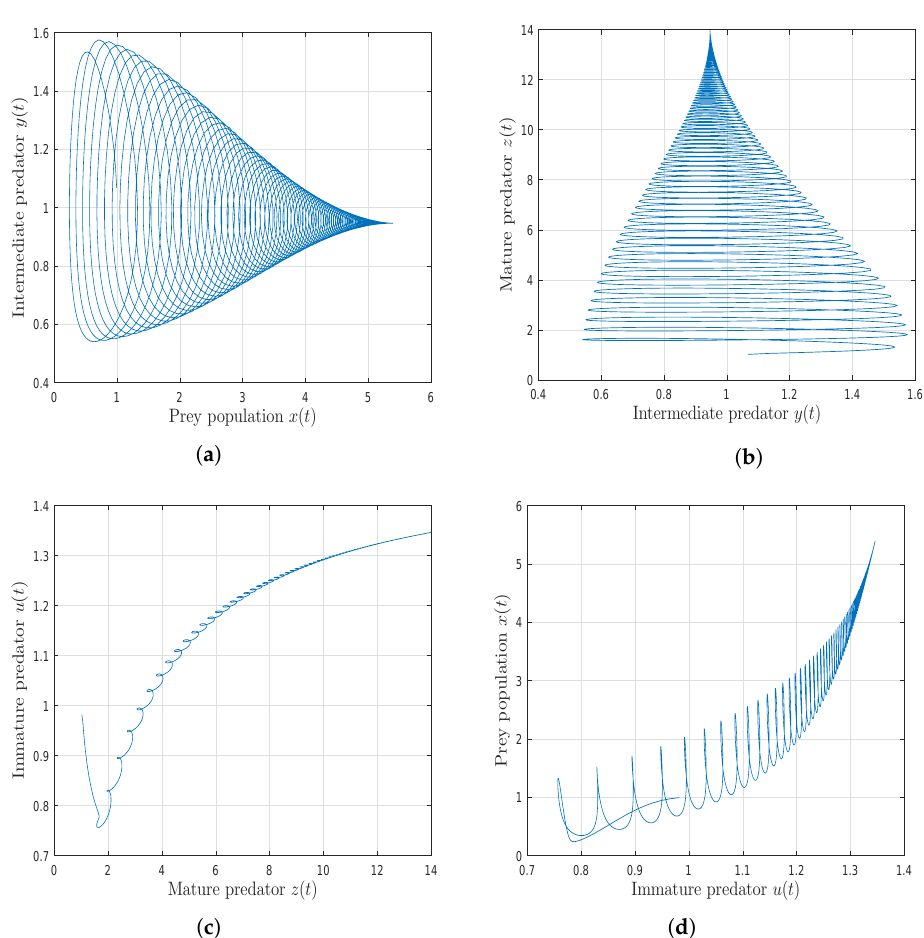
Figure 2. Two-dimensional phase plot for food web mathematical System (13) with generalized Caputo fractional operator when ϕ = 1 and ρ = 1.1.